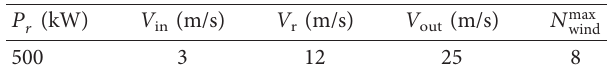
Figure 4: Reactive power data of load at each node. Table 2: Wind generator parameter.